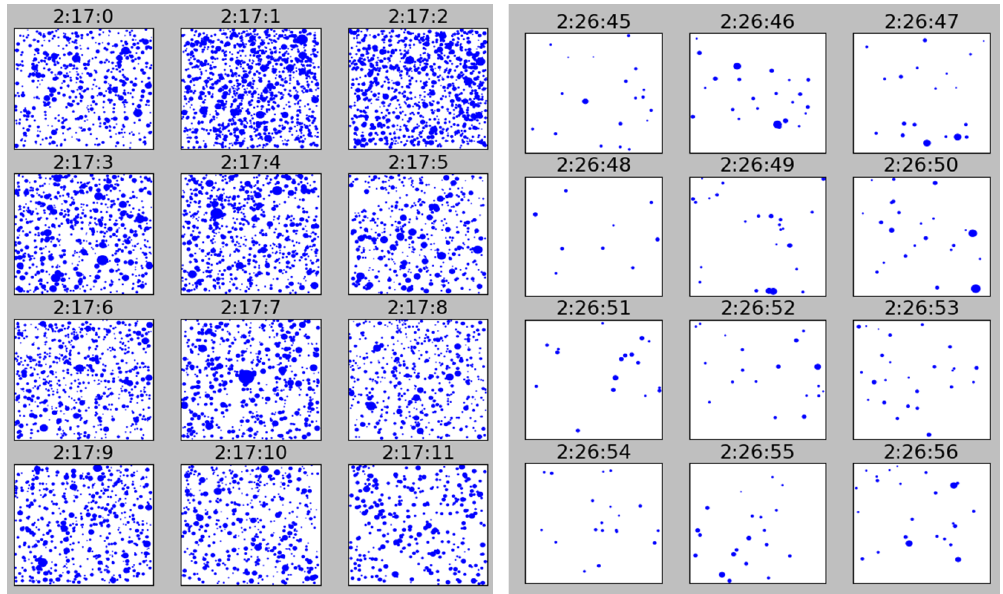
Figure 4. Representation of drop by drop data collected by a 2-D video disdrometer during an event that occurred on 24 September 2012 in Ardèche, France. Each plot corresponds to 1s and the corresponding time is indicated above it. The size of the sampling area is 11cm × 11cm. Raw data provided by Laboratoire de Télédétection en Environnement of Ecole Polytechnique Fédérale de